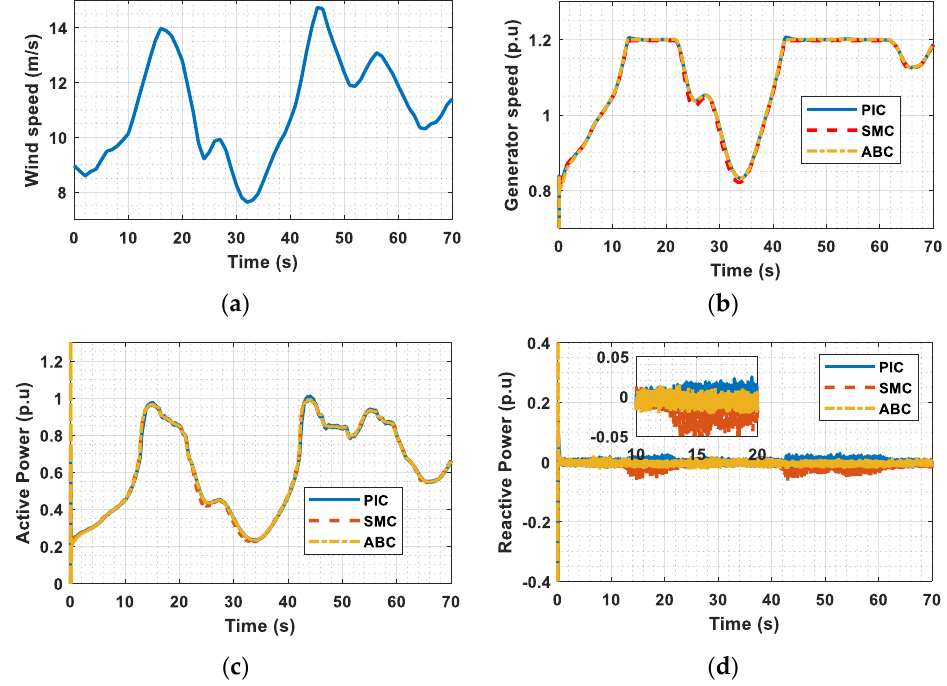
Figure 9. Controllers’ performances in p.u. ( a ) Speed of incident wind, ( b ) Generator speed, ( c ) PCC Active power, and ( d ) PCC Reactive power.